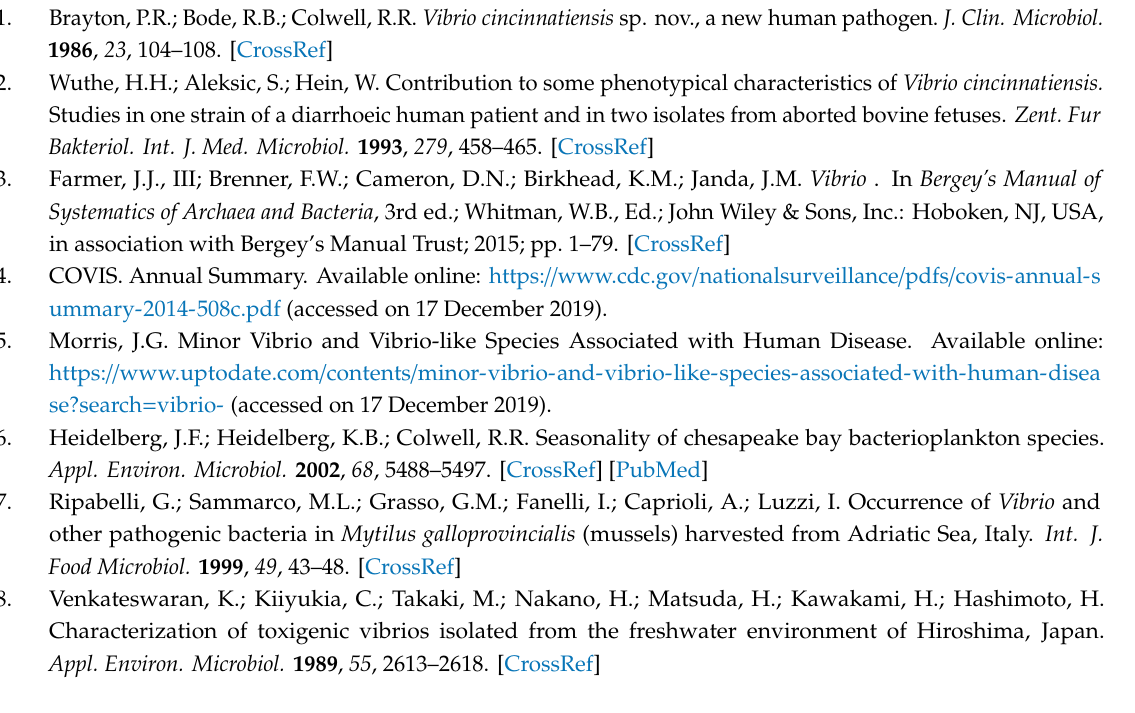
Table S1: Results of the whole-genome sequence analysis of Vibrio cincinnatiensis strains analyzed in this study; Table S2: Minimal inhibition concentrations and resistance profiles of V. cincinnatiensis strains; Table S3: SNP distance matrix of V. cincinnatiensis strains; Table S4: V. cincinnatiensis : Biochemical and phenotypical characterization of veterinary isolates and reference strain NCTC